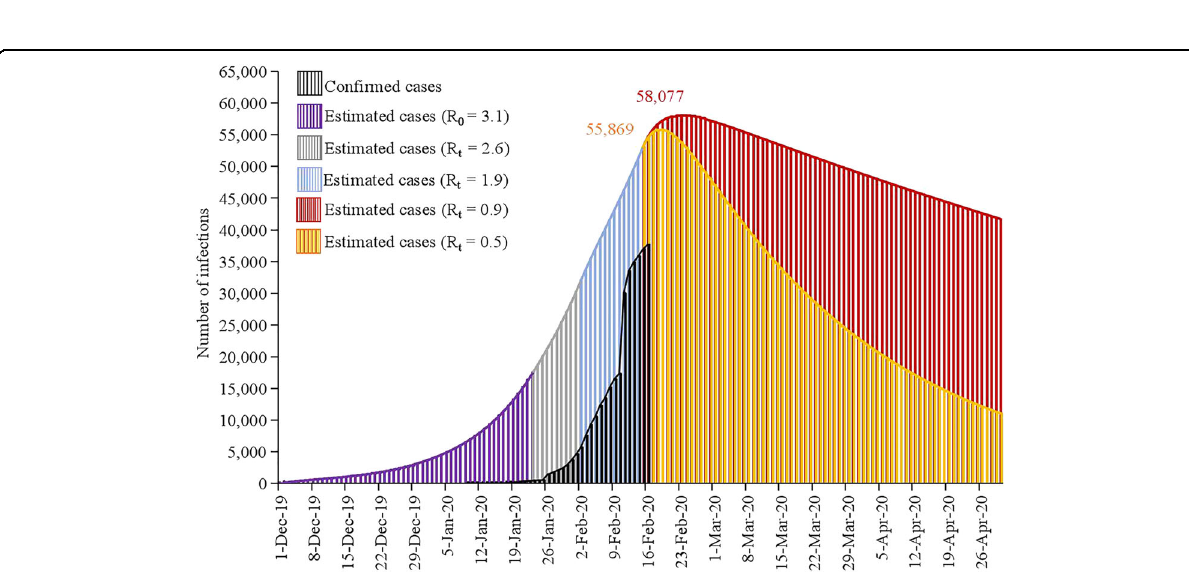
Fig. 1 Estimation of the number of COVID-19 cases in Wuhan, China (December 2019 – February 2020, R 0 = 1.9, 2.6, and 3.1). In all, 11,044, 70,258, and 227,989 represent the estimated number of COVID-19 cases by the end of February 2020 in Wuhan, China, with R 0 = 1.9, 2.6, and 3.1,